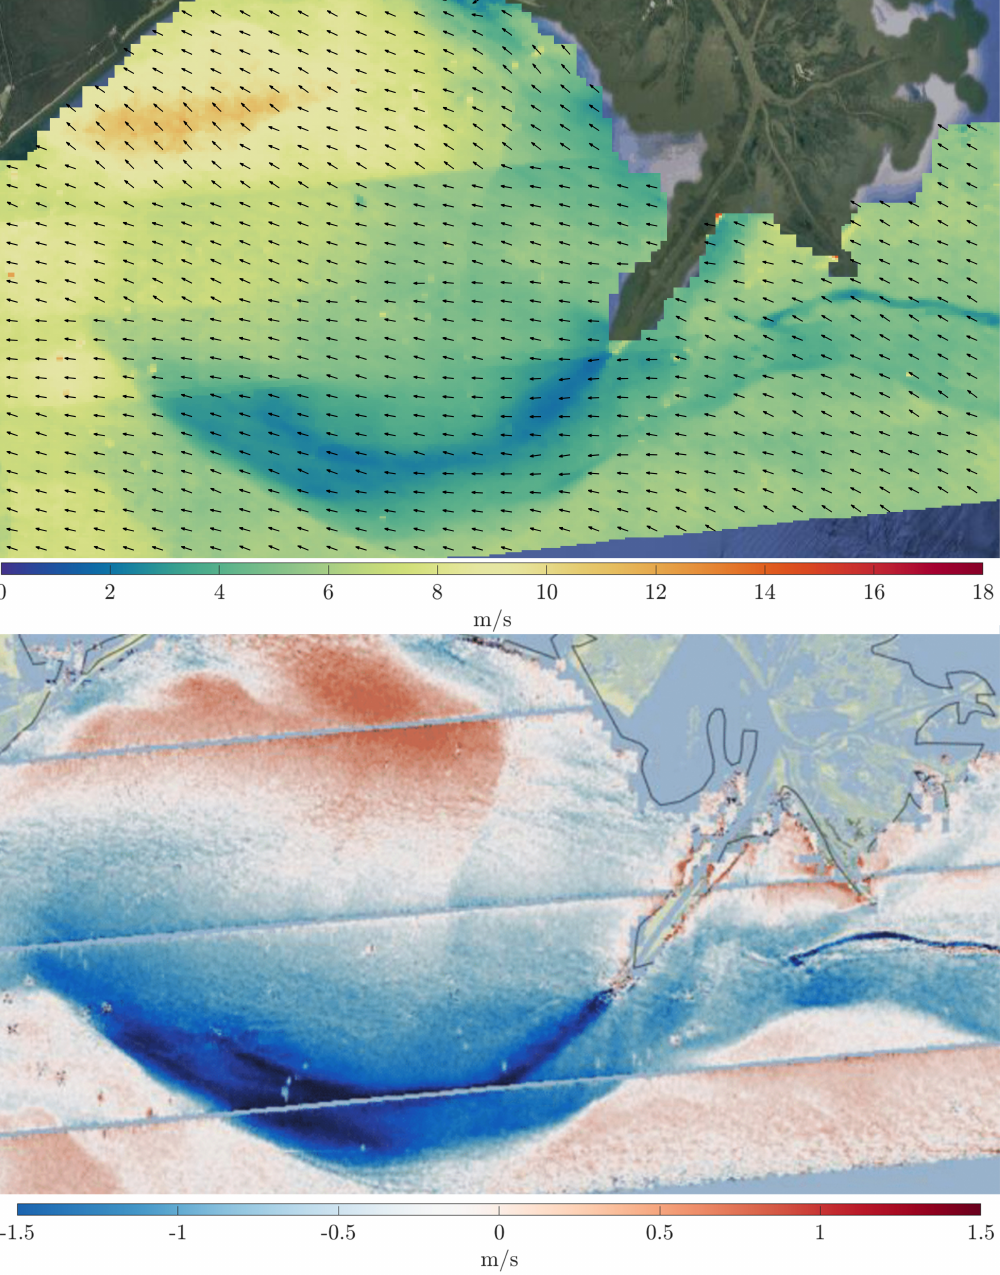
Figure 11. Top : Wind vectors as measured by DopplerScatt in April of 2017 near the outlet of the Mississippi river, in the gulf of Mexico. Bottom : U (East-West) component of vector surface currents as measured by DopplerScatt in the same region, after removal of the wind-driven